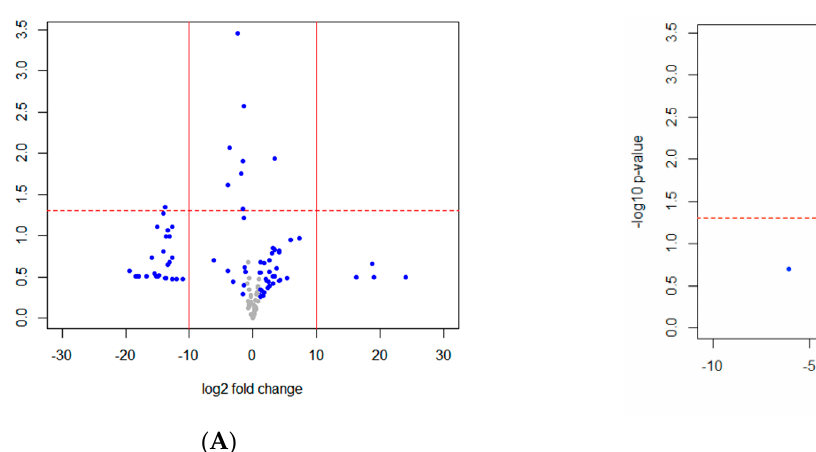
Figure 4. ( A ) Volcano plot showing the differences of gut microbiota in AD-NC versus AD-C (Gc_a). A small number (AD-NC: 0.000002, AD-C: 0.000012) was added to the mean abundance of every bacterium to avoid the value of magnitude of fold change being infinitely large or small. Each point represents a bacterium with its magnitude fold change (log2 of relative abundance) on the x -axis and the value of statistical significance ( − log10 of p value) on the y -axis. The dashed red line shows where p = 0.05, with points above the line having p < 0.05 and points below the line having p > 0.05. Points having magnitude of fold change less than 1 are shown in grey. Points outside of the solid lines are bacteria with 0 abundance in one of the groups. ( B ) Volcano plot of log2 fold change from − 10 to 10 shows degree of magnitude in relative abundance of bacteria substantially greater in decreasing (green box) than increasing (red box).